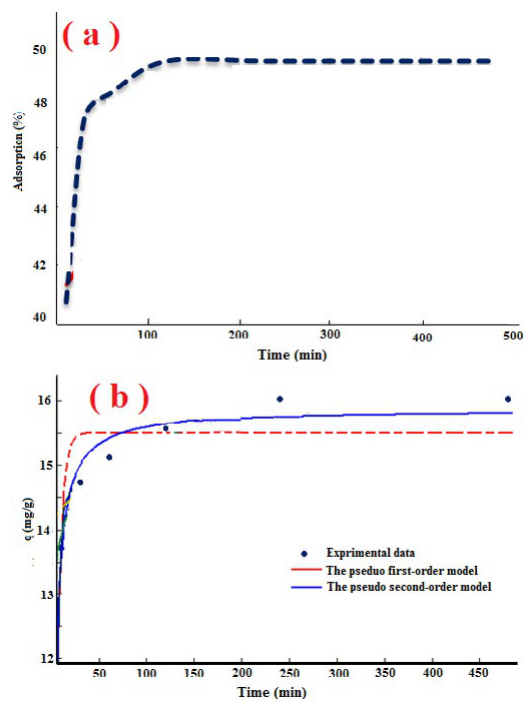
Fig. 3 (a) Effect of contact time on Cd(II) adsorptions and (b) Kinetic models plots of Cd(II) adsorptions on modified Fig. 3: (a) Effect of contact time on Cd(II) adsorptions and (b) zeolite Kinetic models plots of Cd(II) adsorptions on modified